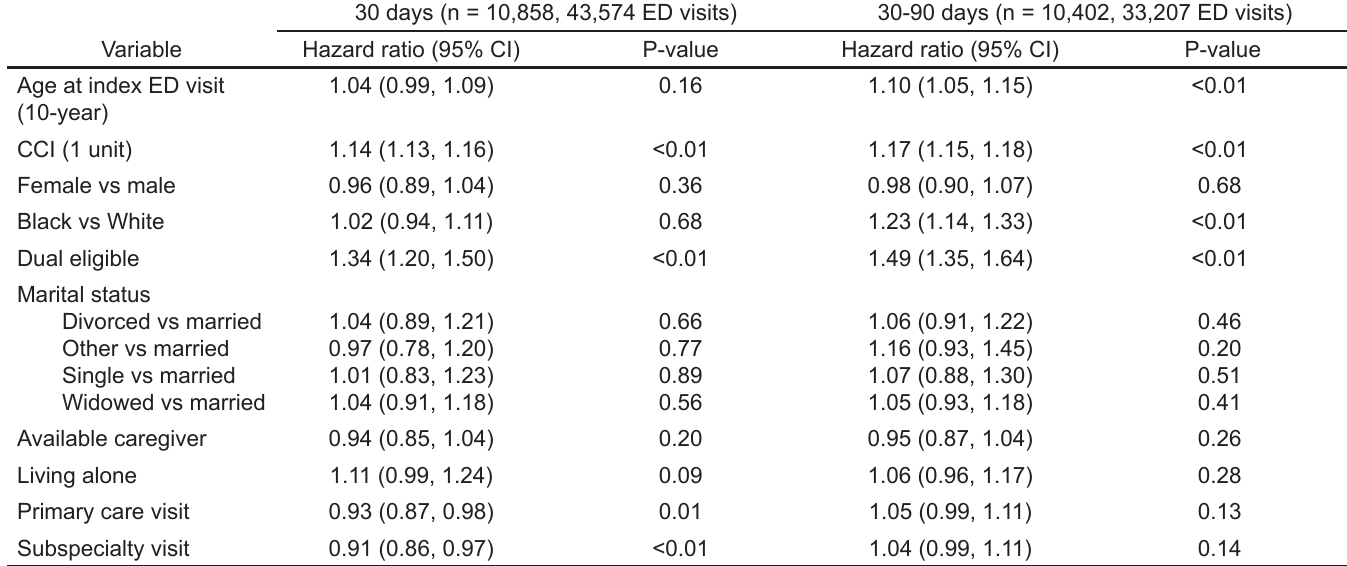
Table 2. Multivariable Cox proportional hazard models on time to repeated emergency department visit.